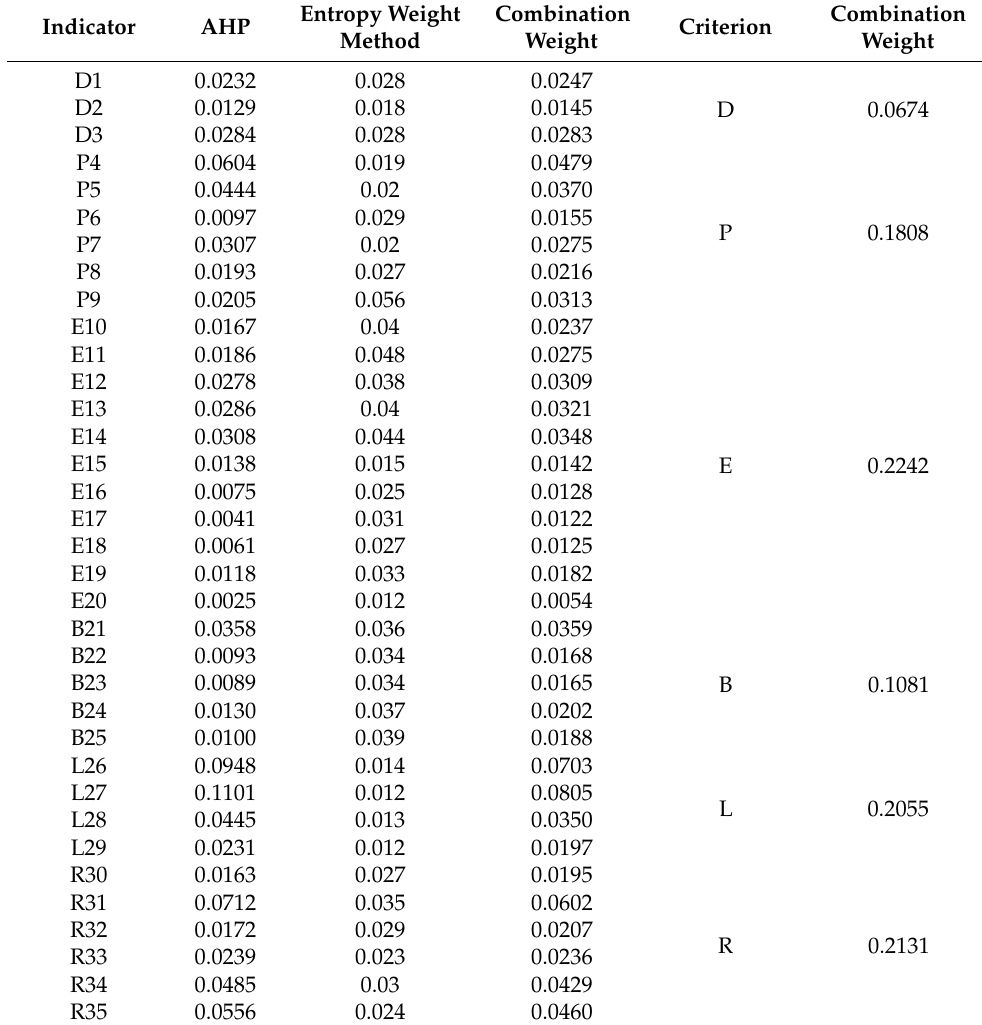
Table 5. The weight calculation results of Chongqing water security evaluation indicators (2011–2019). Indicator